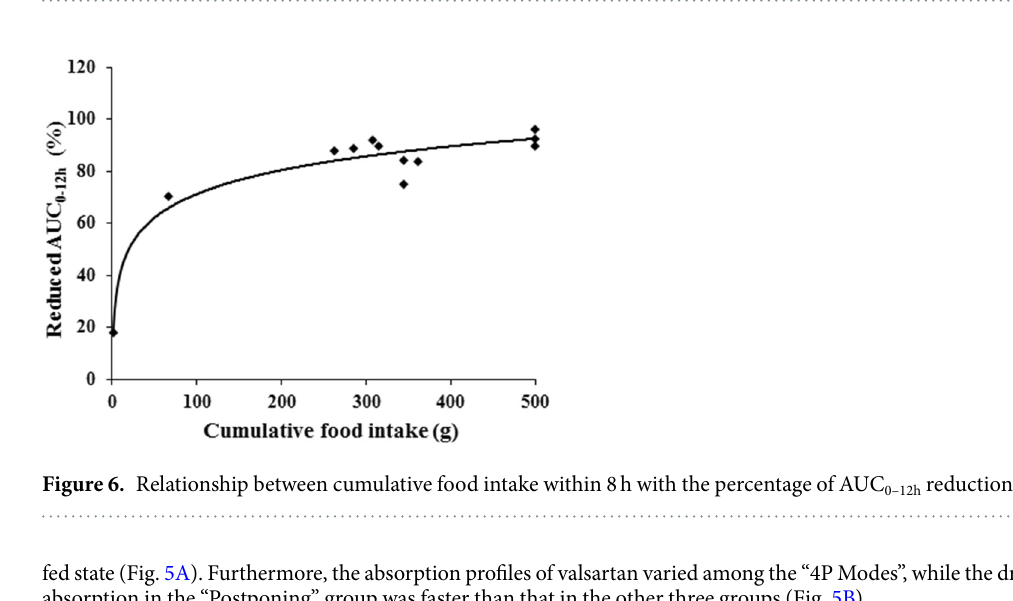
Figure 5. Absorption-time profiles of valsartan capsules varied by food taking in beagles. Fasted and fed state (n = 12). ( A ) “4P Modes” after a single oral dose of 80 mg valsartan per beagle ( B ).